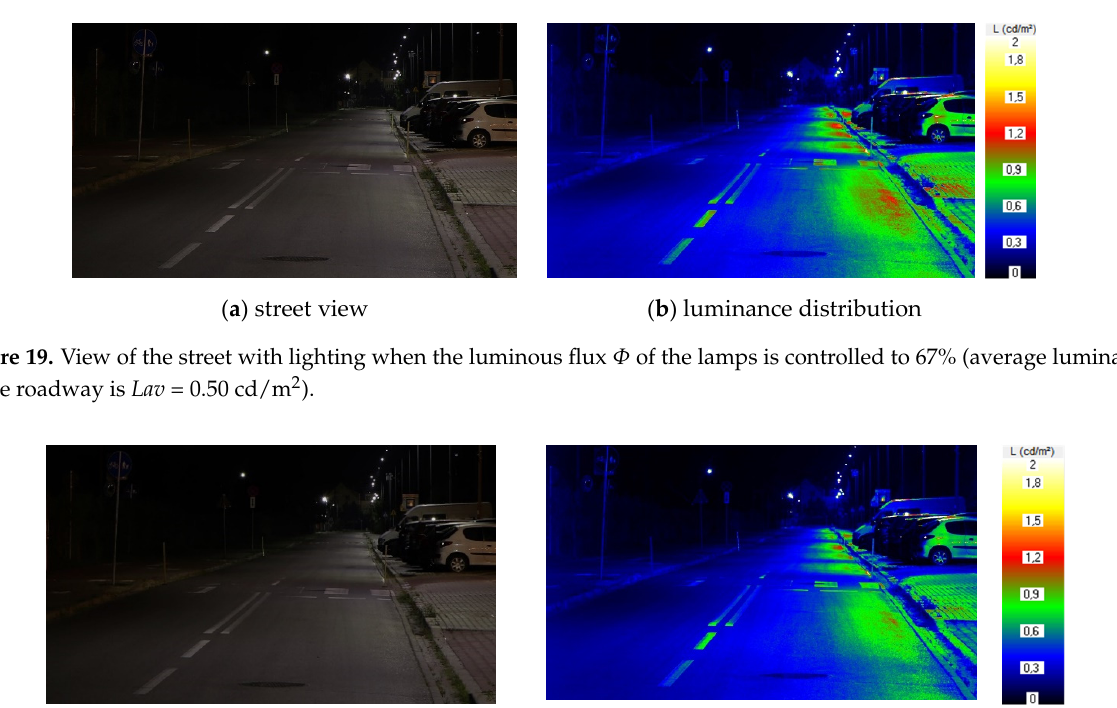
Figure 18. View of the street with lighting when the luminous flux Φ of the lamps is controlled to 91% (average luminance of the roadway is Lav = 0.68 cd/m 2 ).